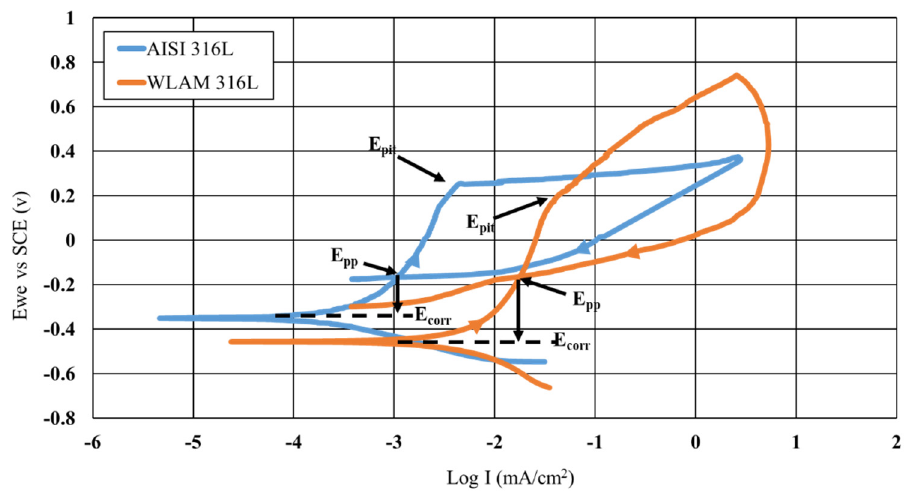
Figure 9. Cyclic potentiodynamic polarization analysis of WLAM 316L stainless steel and its counterpart AISI 316L alloy. Table 2. Electrochemical parameters derived from potentiodynamic polarization analysis shown in Figure 9.